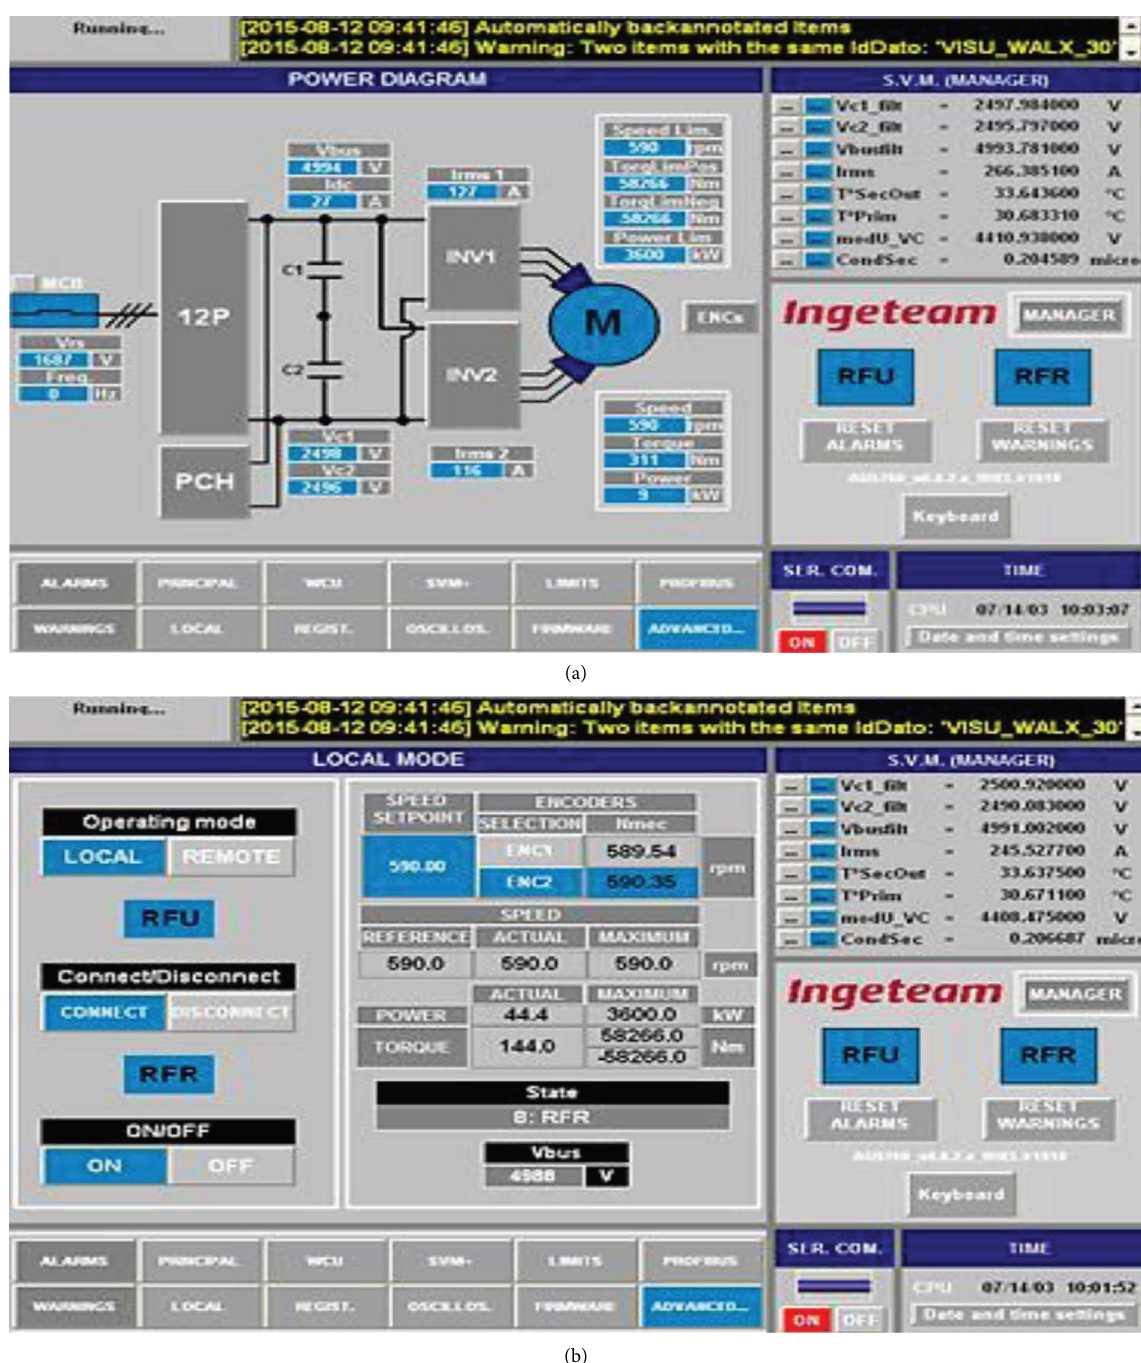
Figure 20: HMI screen of the VFD panel in the power